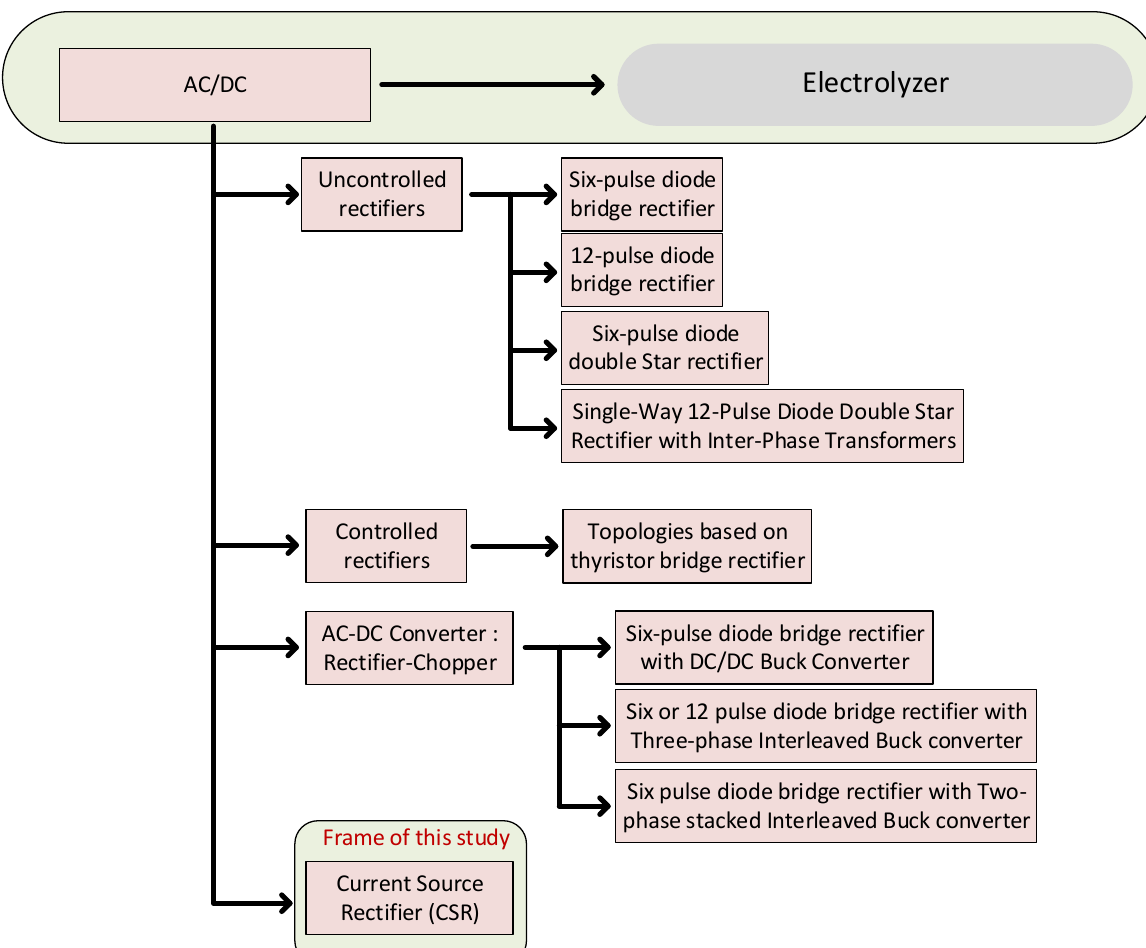
Figure 2. Energy conversion systems used to power an